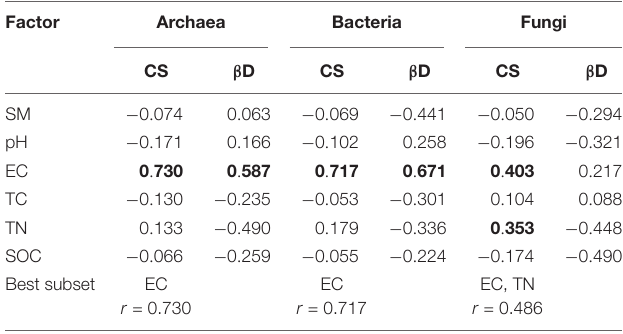
TABLE 2 | Spearman’s correlation between soil microbial community structure (CS), β -null deviation ( β D), and soil properties (0–10 cm soil layer). Factor Archaea Bacteria